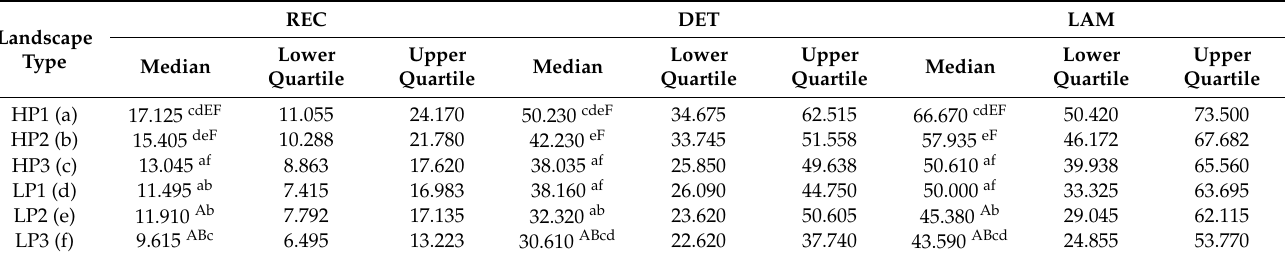
Table 3. Differences in the visual behavior coincidence degree across forest